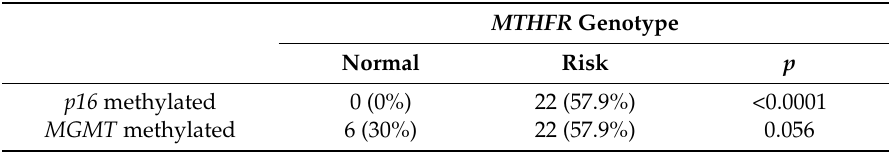
Table 3. Analysis of the influence of the MTHFR genotype on either p16 gene promoter methylation or MGMT promoter methylation in OSCC